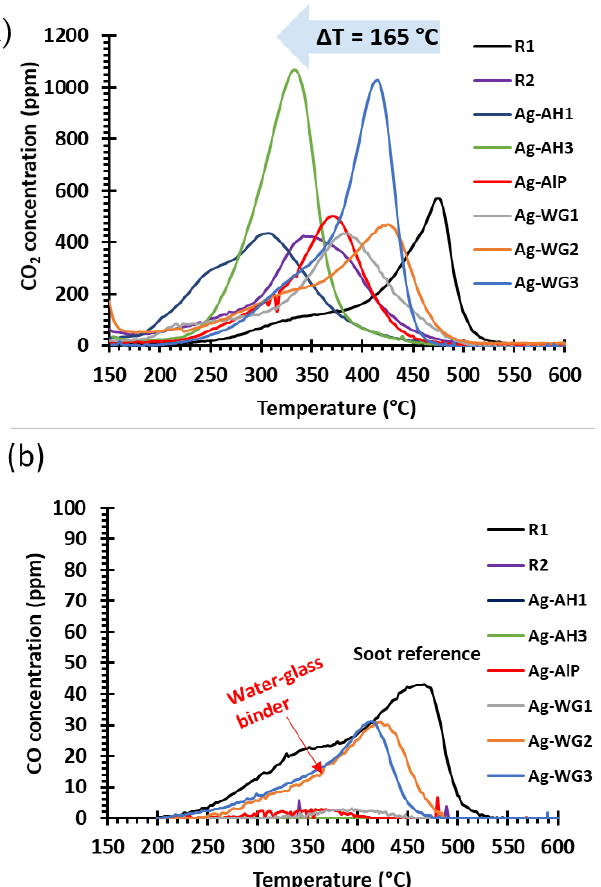
Figure 3. ( a ) Soot-oxidation performance and ( b ) CO formation for the silver catalysts and the soot reference. The di ff erence in the soot-oxidation temperatures of samples R1 and Ag-AH1 was 165 ◦ C. For more details about the catalysts, see Table